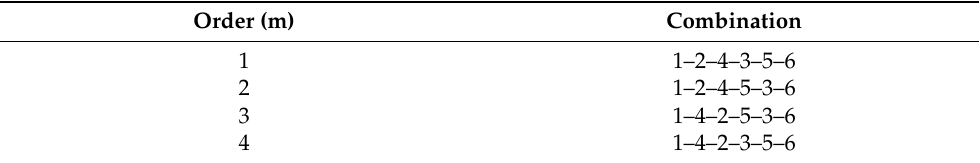
Table 2. Possible orders of DLT probabilities.